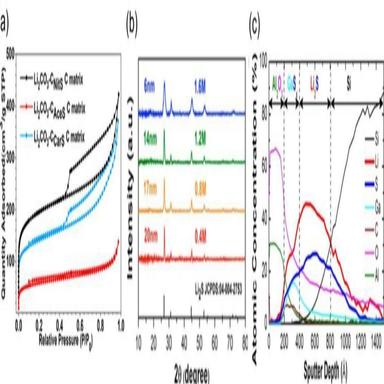
(a) N2 adsorption–desorption isotherms of the carbon matrix after Li2CO3 removal for porosity analaysis . (b) XRD patterns of as-synthesized Li2S-NCs as a function of solution concentration via the reaction between EtOLi and H2S. (c) Atomic concentration versus depth for ALD Li2S/GaSx/Al2O3 tri-layered film prepared using 600 ALD Li2S cycles, 100 ALD GaSx cycles, and 100 ALD Al2O3 cycles at 200 C on a Si(100) substrate, measured by XPS depth profiling analysis . Repr